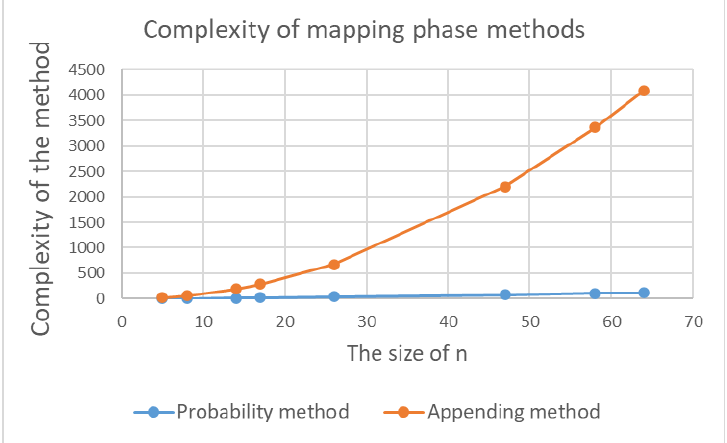
Figure 30. Complexity comparison of probability and appending mapping